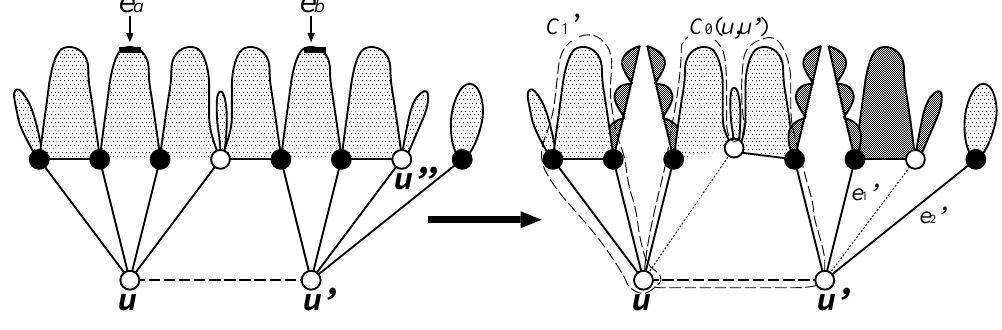
Figure 9. Example of configuration and its resulting subgraph for G dark gray regions and thin dotted lines denote selected vertices, blade, and removed